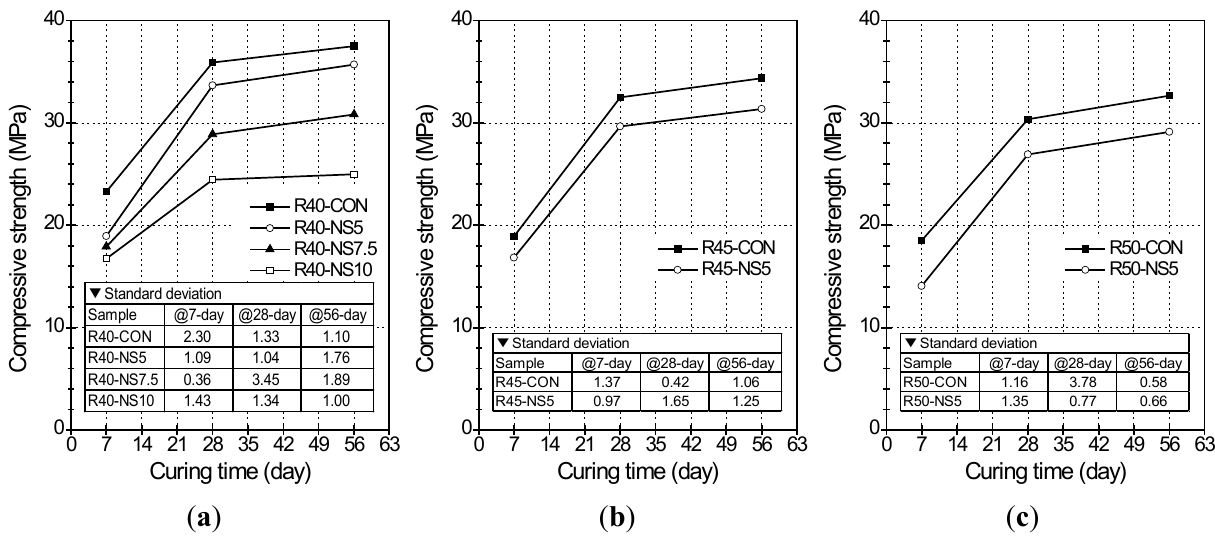
Figure 1. Compressive strength of cylinders with ( a ) water-cement ratio (W/C) of 40%; ( b ) W/C of 45%; and ( c ) W/C of 50% with respect to W/C and curing